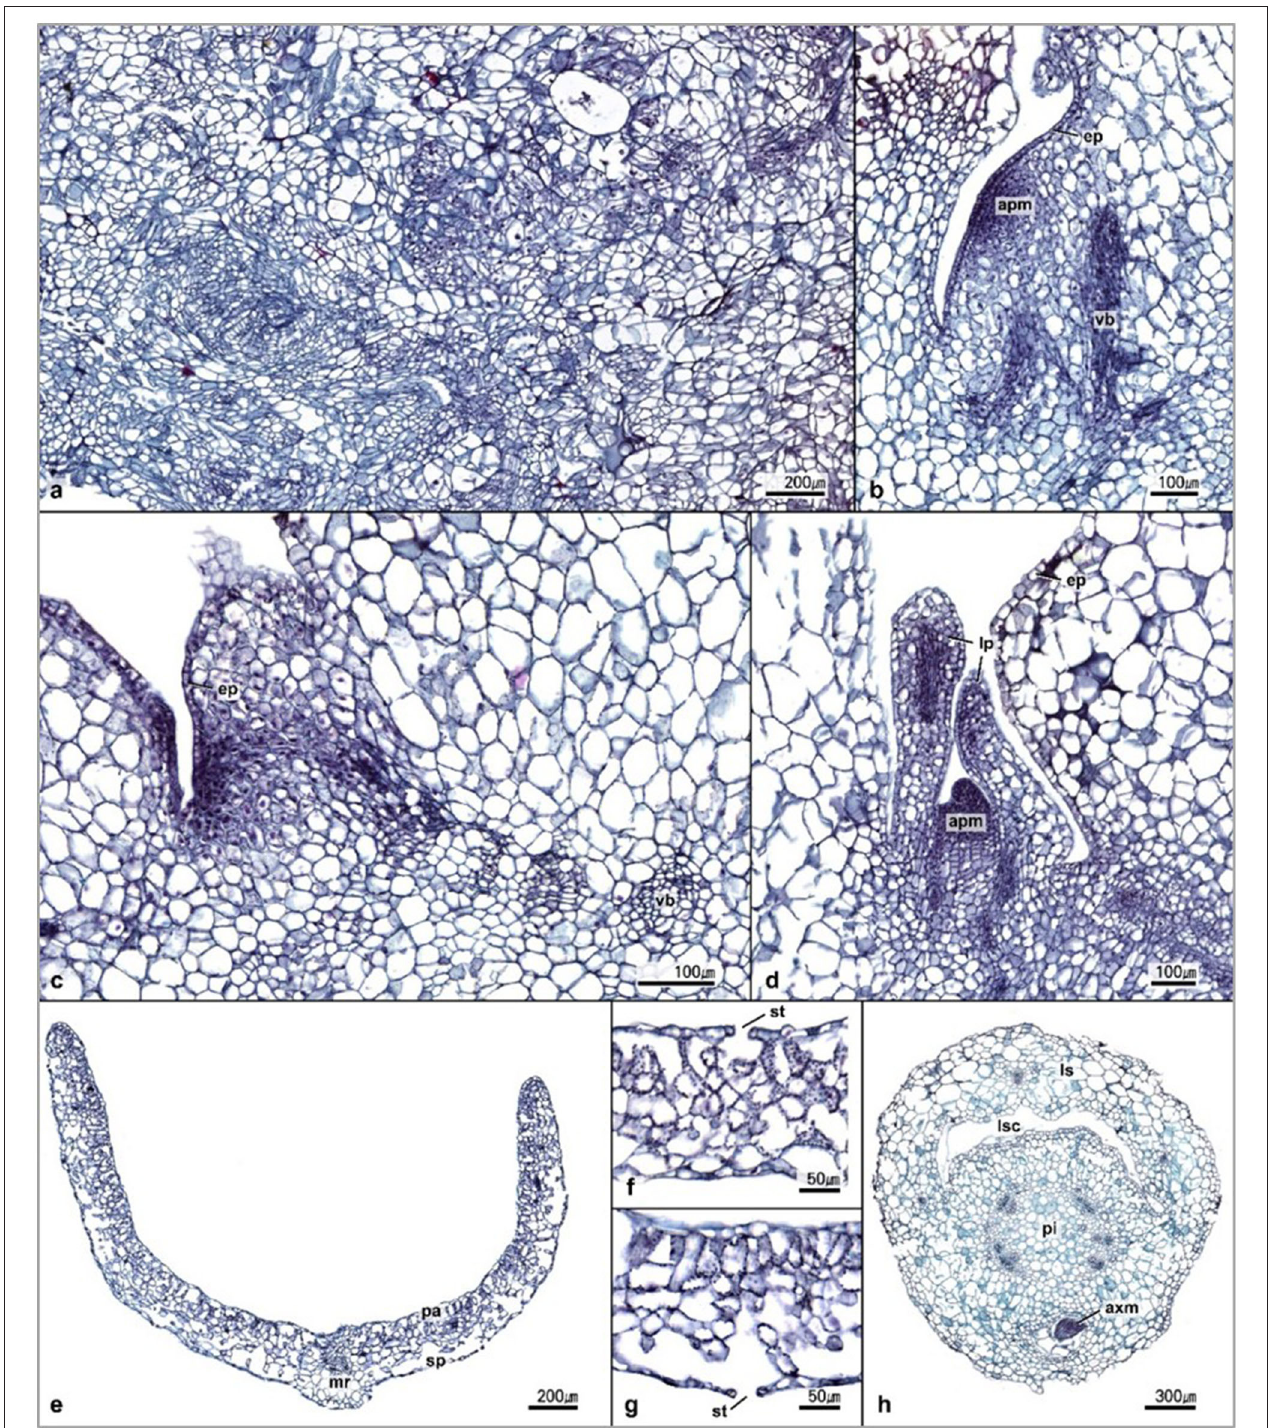
FIGURE 5 | Transverse sections of A. africana . (a) The anatomical structure of callus, (b,c) initiation of shoot apical meristem, (d) shoot apical meristem and leaf primordial, (e–g) transverse section of young leaf, and (h) transverse section of young stem. apm, apical meristem; ep, epidermis; vb, vascular bundle; mr, midrib; pa, palisade parenchyma; sp, sponge parenchyma; st, stomata; lp, leaf primordial; ls, leaf sheath; lsc, leaf sheath canal; pi, pith; axm, axillary meristem.